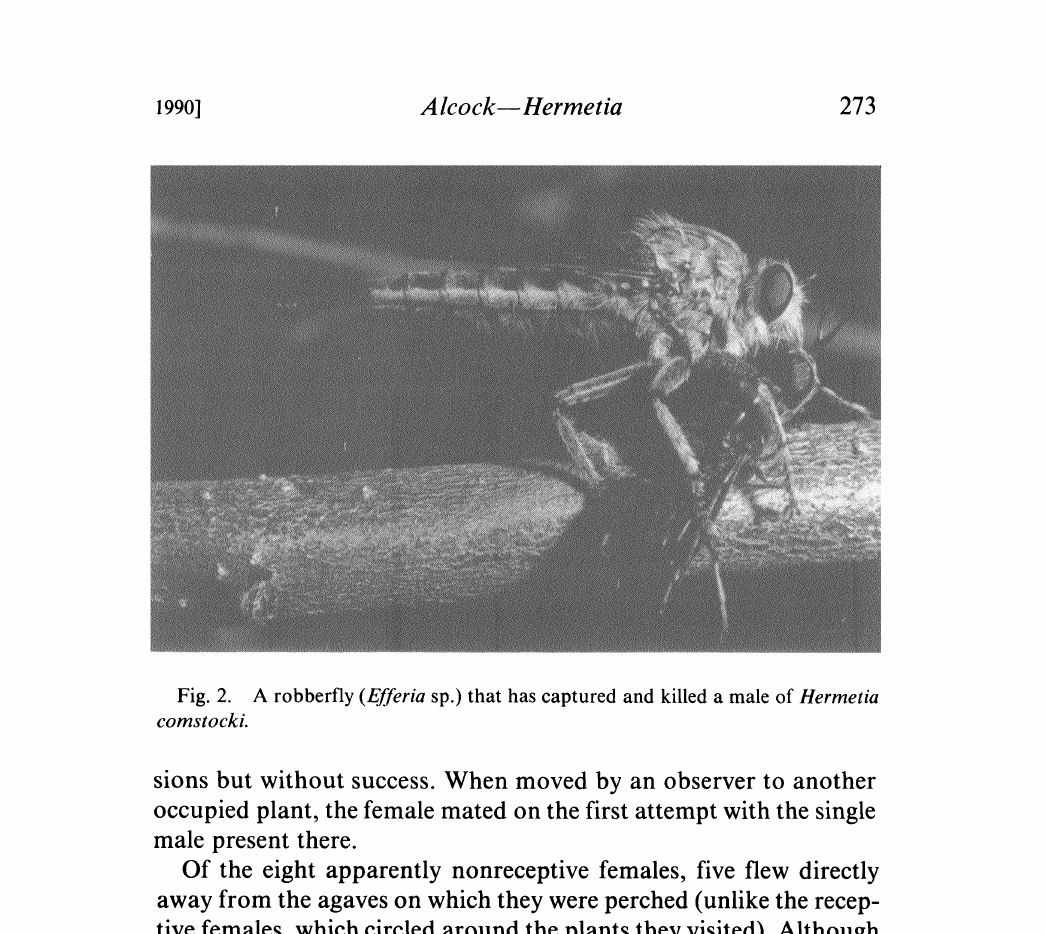
Fig. 2. A robberfly (Efferia sp.) that has captured and killed a male of Hermetia